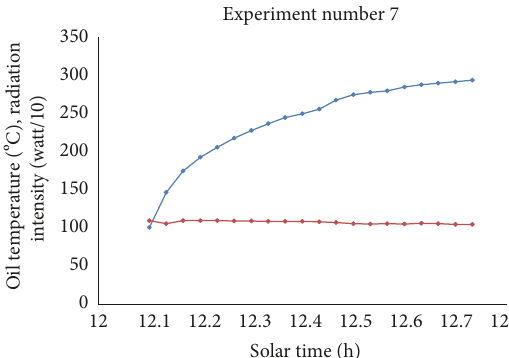
Figure 11: Plot of temperature (blue) and solar radiation intensity (red) versus time for the fi rst experiment with 4kg of water load. Radiation intensity is divided by 10 to fi t the scale.